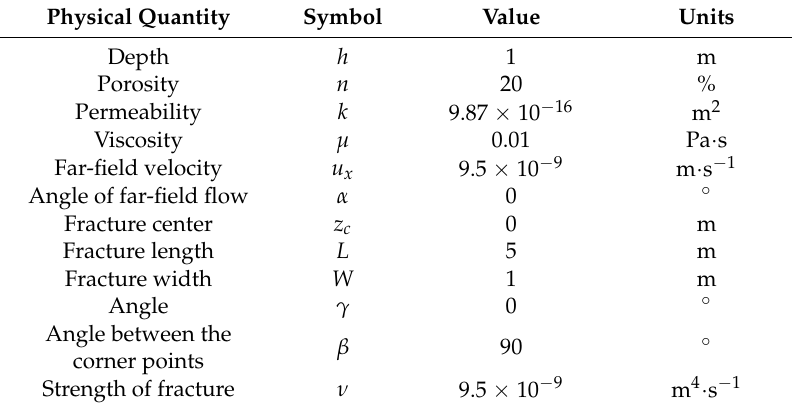
Figure A4. Pressure profile for fracture superposed with far field flow by separating the real and imaginary terms individually. The branch cut seen in Figure A1 has been removed by the applied procedure. Length scale in meters and pressure (rainbow colors) in Pa. Table A1. Properties for pressure field